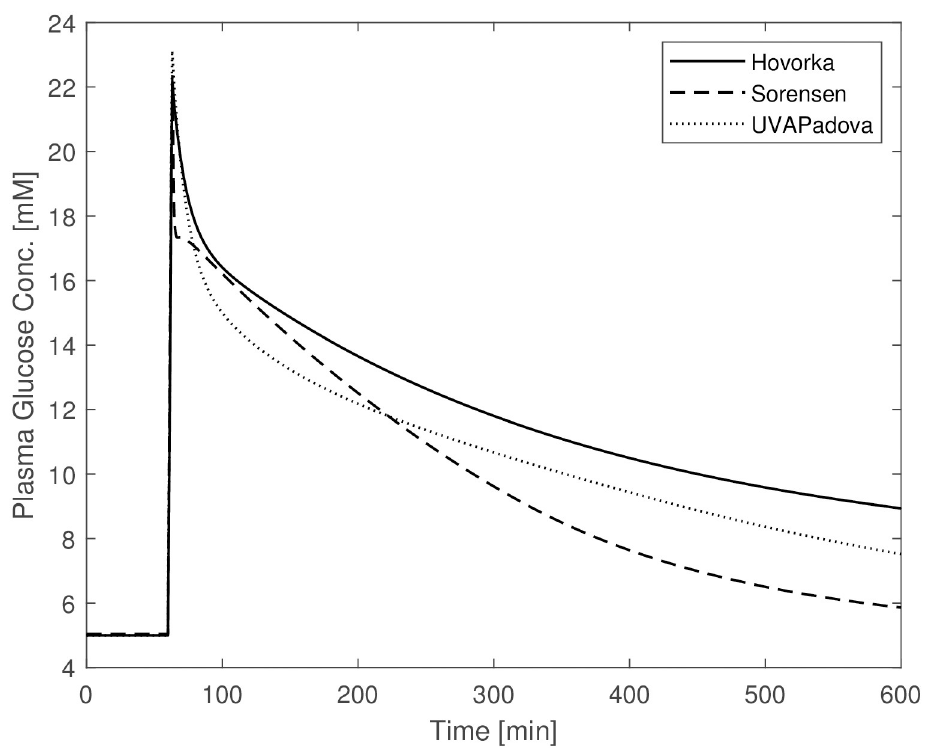
Fig 5. Blood glucose concentrations from the Hovorka (solid line), Sorensen (dashed line) and UVAPadova (dotted line) models, during the in-silico IVGTT experiment.